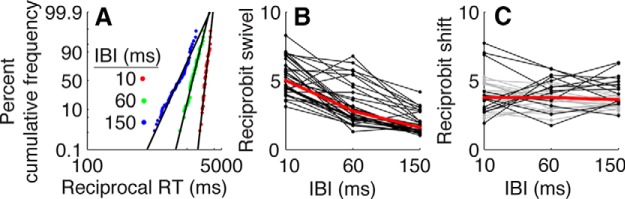
LATER model fits to signal RT data. A, Distributions of signal RT from 0%-coherence trials for one subject are plotted on a reciprobit plot: reciprocal RT versus percentage of cumulative frequency on a probit scale (Reddi et al., 2003), separately per IBI. Best-fitting values of the bound height (B) and mean rate-of-rise (C) of the LATER model (see Results and Materials and Methods for details) are plotted as a function of IBI for each subject and coherence (black/gray lines and data points). The data in black indicate that the model fits were improved significantly by fitting the given parameter separately for each IBI condition (likelihood-ratio test, p < 0.01, Bonferroni-corrected for two parameters). Shaded lines/symbols indicate that the model fits were not improved significantly. Red data points/lines represent the median values across all conditions.